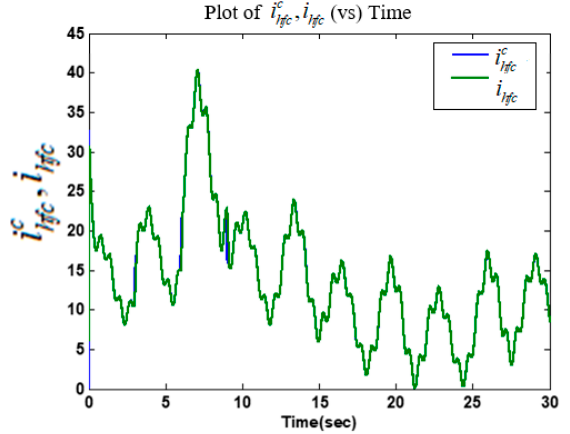
Figure 7. Time history of HFC command profile i c